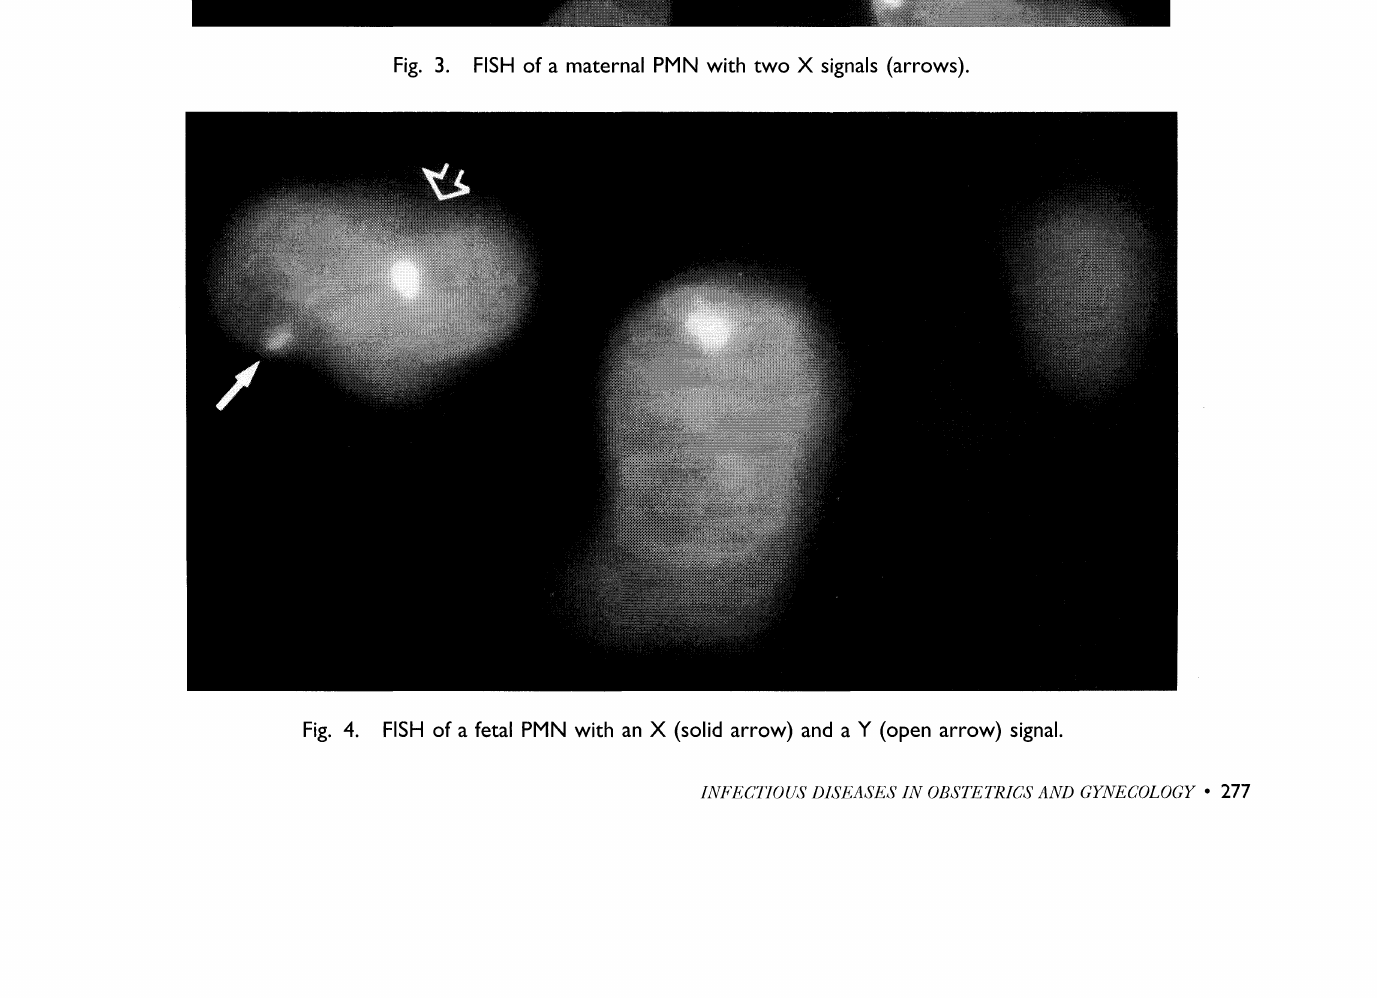
Fig. 3. FISH of a maternal PMN with two X signals (arrows).